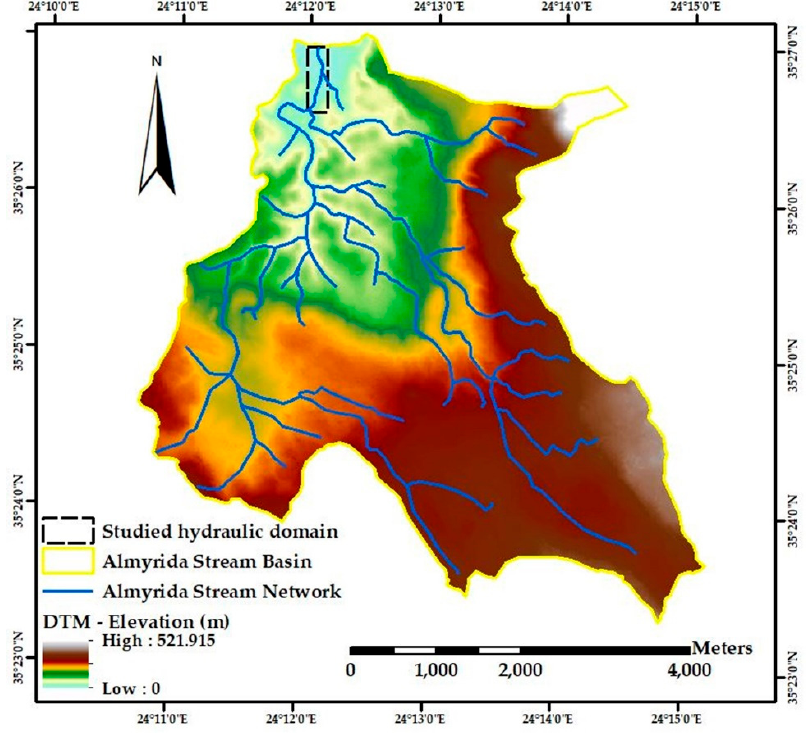
Figure 1. Almyrida stream basin.